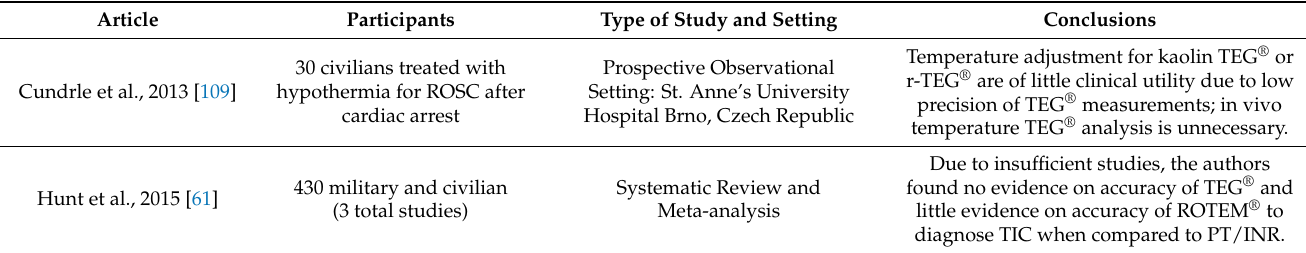
Table 2. Summary of literature investigating environmental influence on VHA